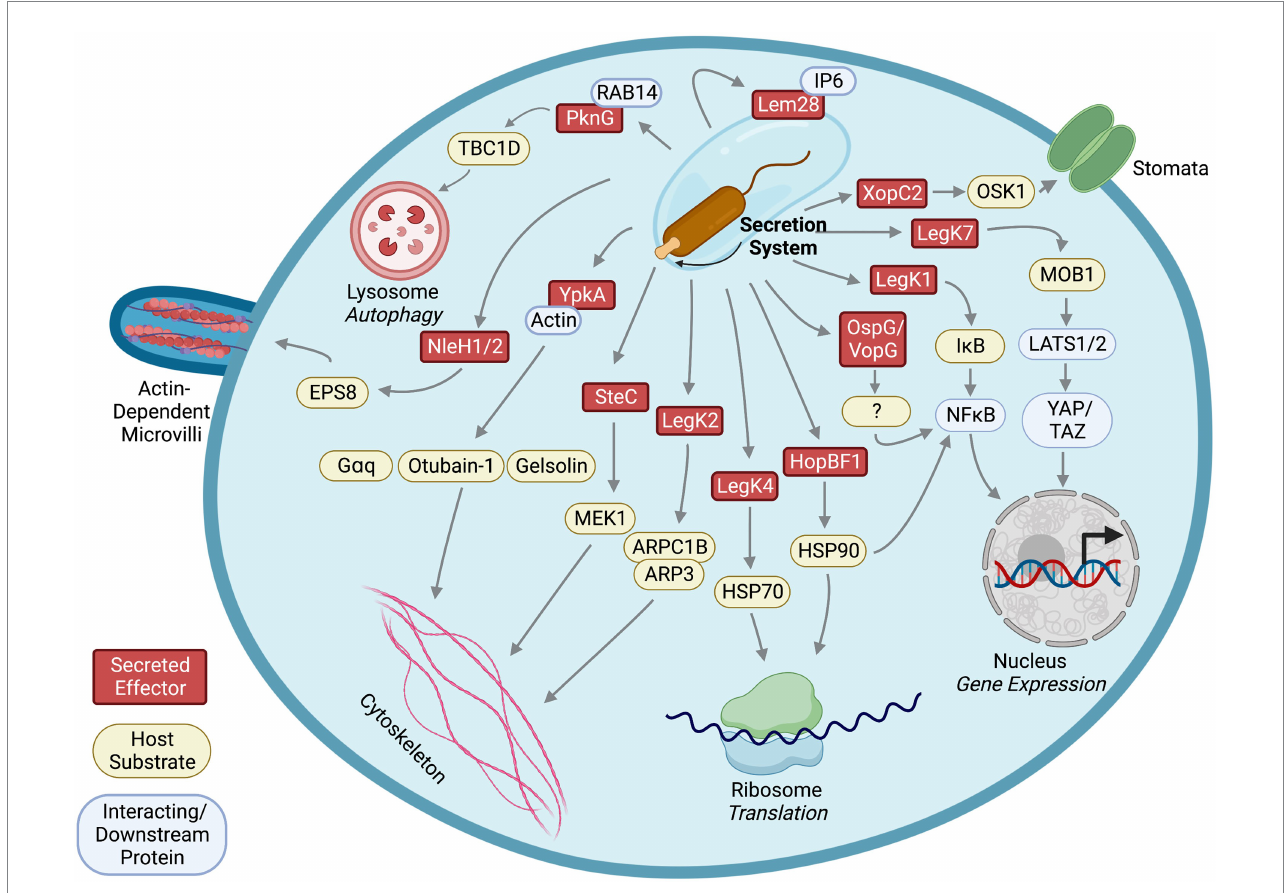
FIGURE 2 Identified effector kinases, their host substrates, interacting partners, and downstream affected pathways.